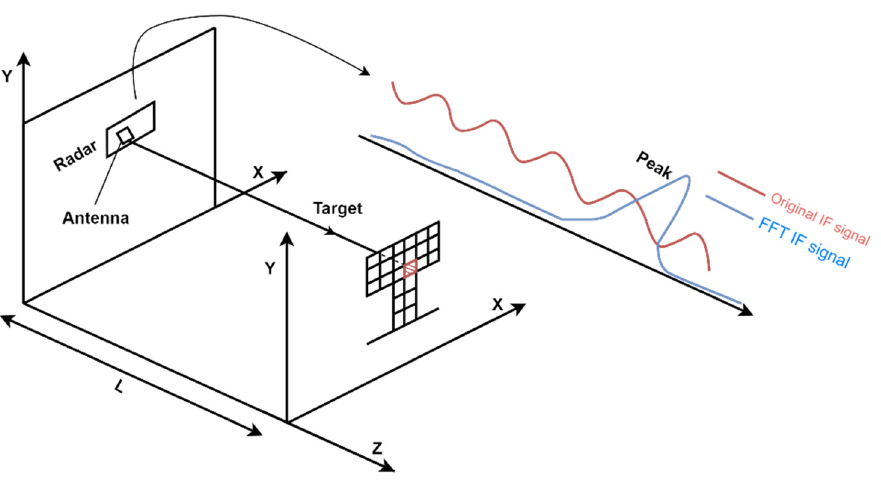
Figure 2. Radar test target distance.